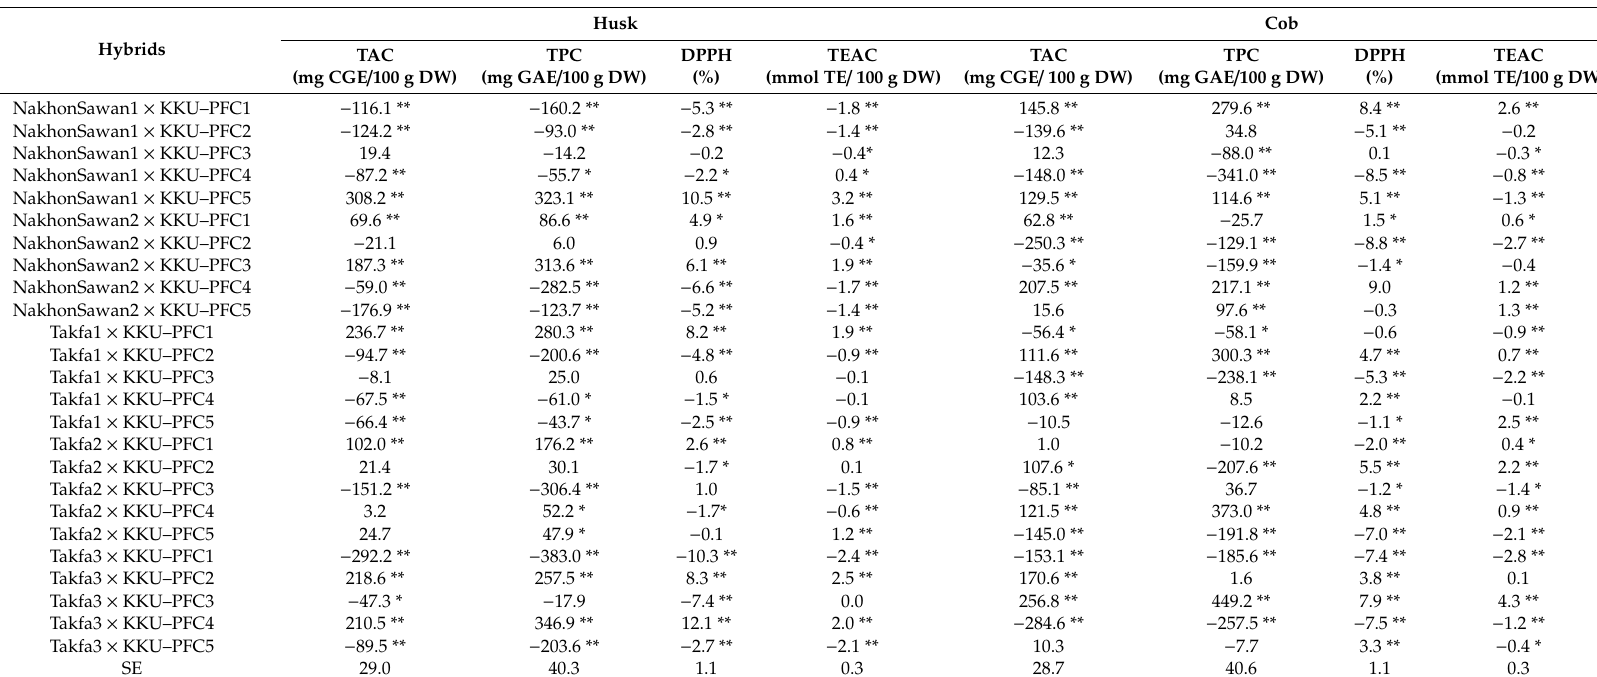
Table 10. Specific combining ability e ff ects (SCA) for total anthocyanin content (TAC), total phenolic content (TPC), and antioxidant activity determined by DPPH and TEAC method of hybrids across two